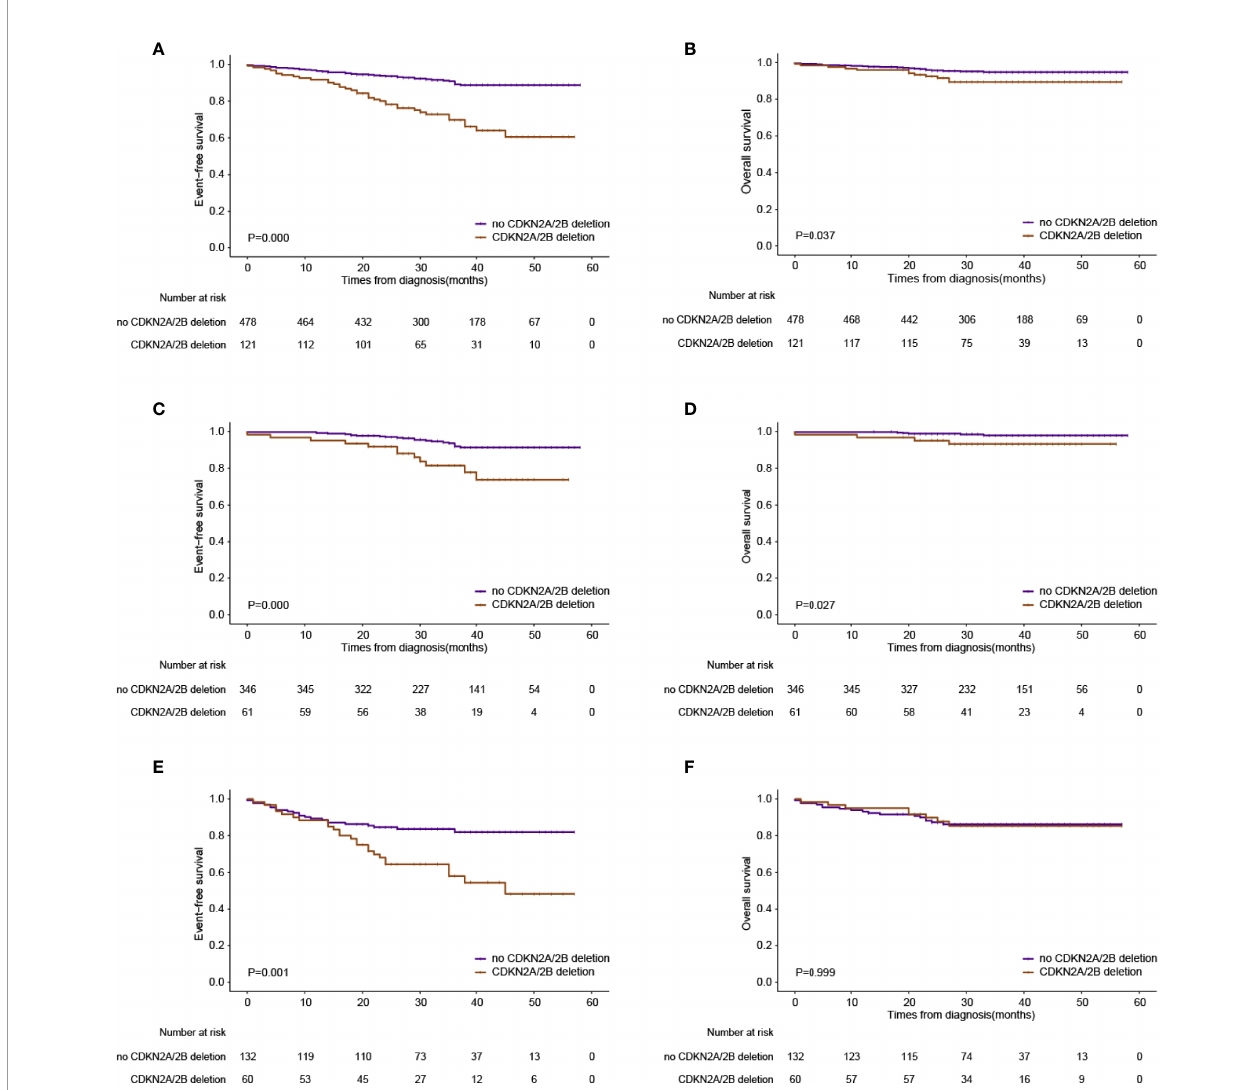
FIGURE 2 | Outcomes based on the presence or absence of CDKN2A deletions. (A) Event-free survival in the whole series. (B) Overall survival in the whole series. (C) Event-free survival in the low-risk group. (D) Overall survival in the low-risk group. (E) Event-free survival in the intermediate-risk group. (F) Overall survival in the intermediate-risk